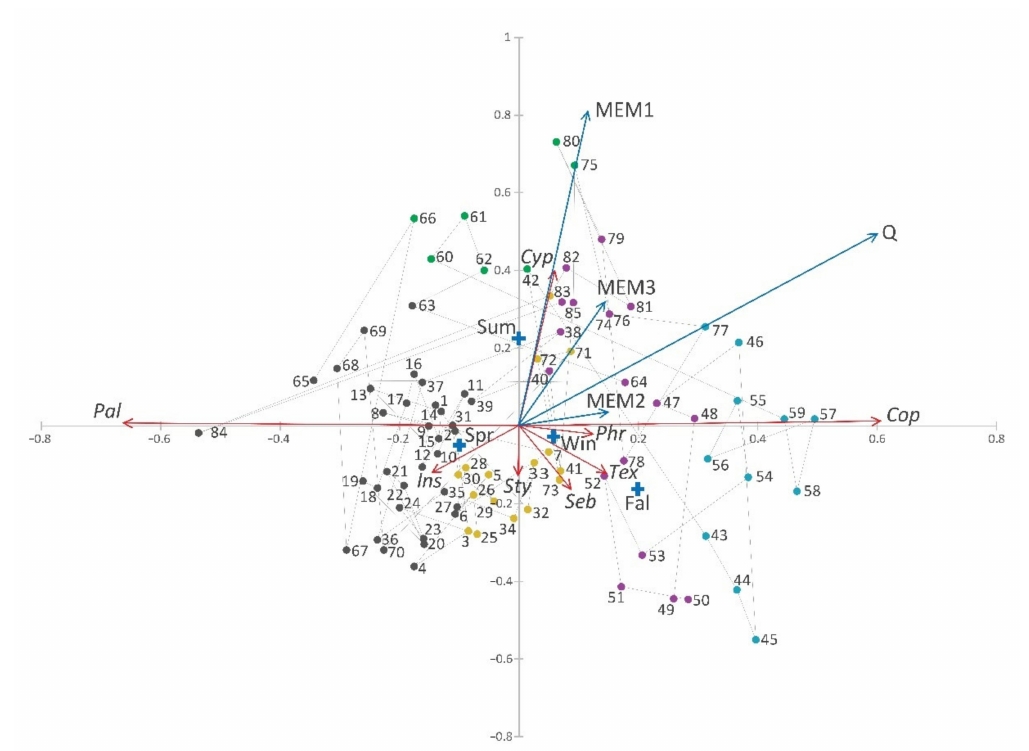
Figure 5. First two axes of global Redundancy Analysis for stygobionts from high-frequency sampling at the San Marcos Artesian Well. Sample numbers refer to sample order (e.g., 01 occurred at T 0 , followed by 02) but time between consecutive samples is variable. Sample colors refer to Ward’s minimum variance clustering (Figure 3): green = cluster 1, black = cluster 2, light blue = cluster 3, yellow = cluster 4, and purple = cluster 5. Faint lines connect consecutive samples. For clarity, only taxa with the highest loadings on axes 1 and 2 are shown (red arrows): Cyp = Cypria lacrima, Phr = Phreatodrobia plana , Tex = Texiweckelia texensis , Seb = Seborgia relicta , Sty = Stygobromus flagellatus, Ins = Texiweckeliopsis insolita, and Pal = Palaemon antrorum. Blue arrows show biplot scores for constraining variables: Q = discharge, MEM1–MEM3 represent significant Moran’s eigenvector maps describing temporal relationships among samples at different scales. Blue pluses are centroids for categorical seasons: Sum = summer, Spr = spring, Win = winter, and Fal =